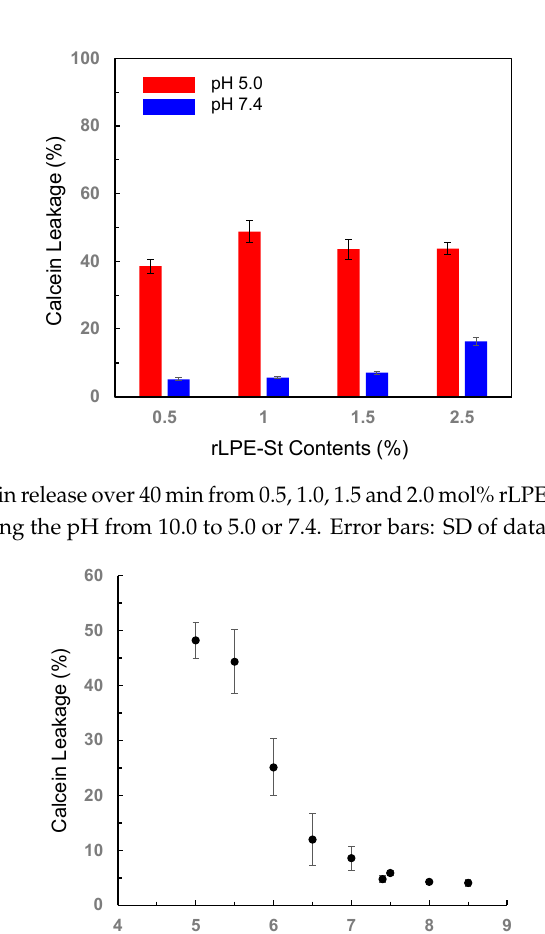
Figure 4. pH-selective calcein release behavior from liposomes anchoring the 1.0 mol% of rLPE-St. The calcein-entrapped liposomes were prepared at pH 10.0. After 5 min incubation, the pH was lowered to a value of 7.4 or 5.0.